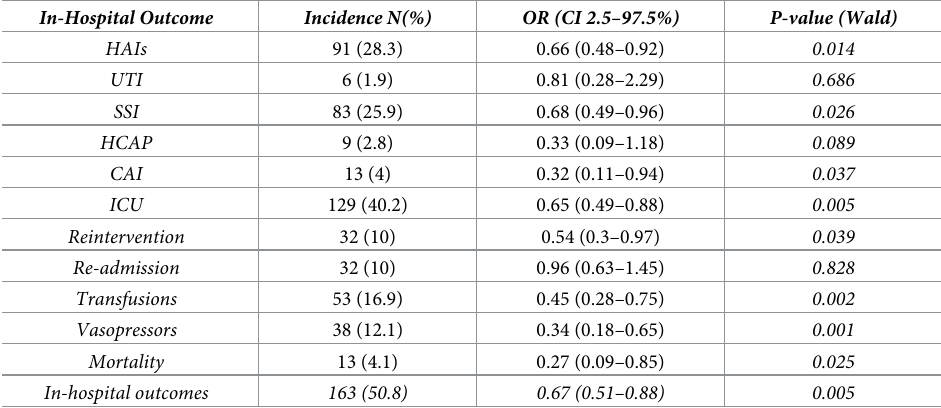
Table 2. Associations between serum vitamin D concentration and In-hospital outcomes.